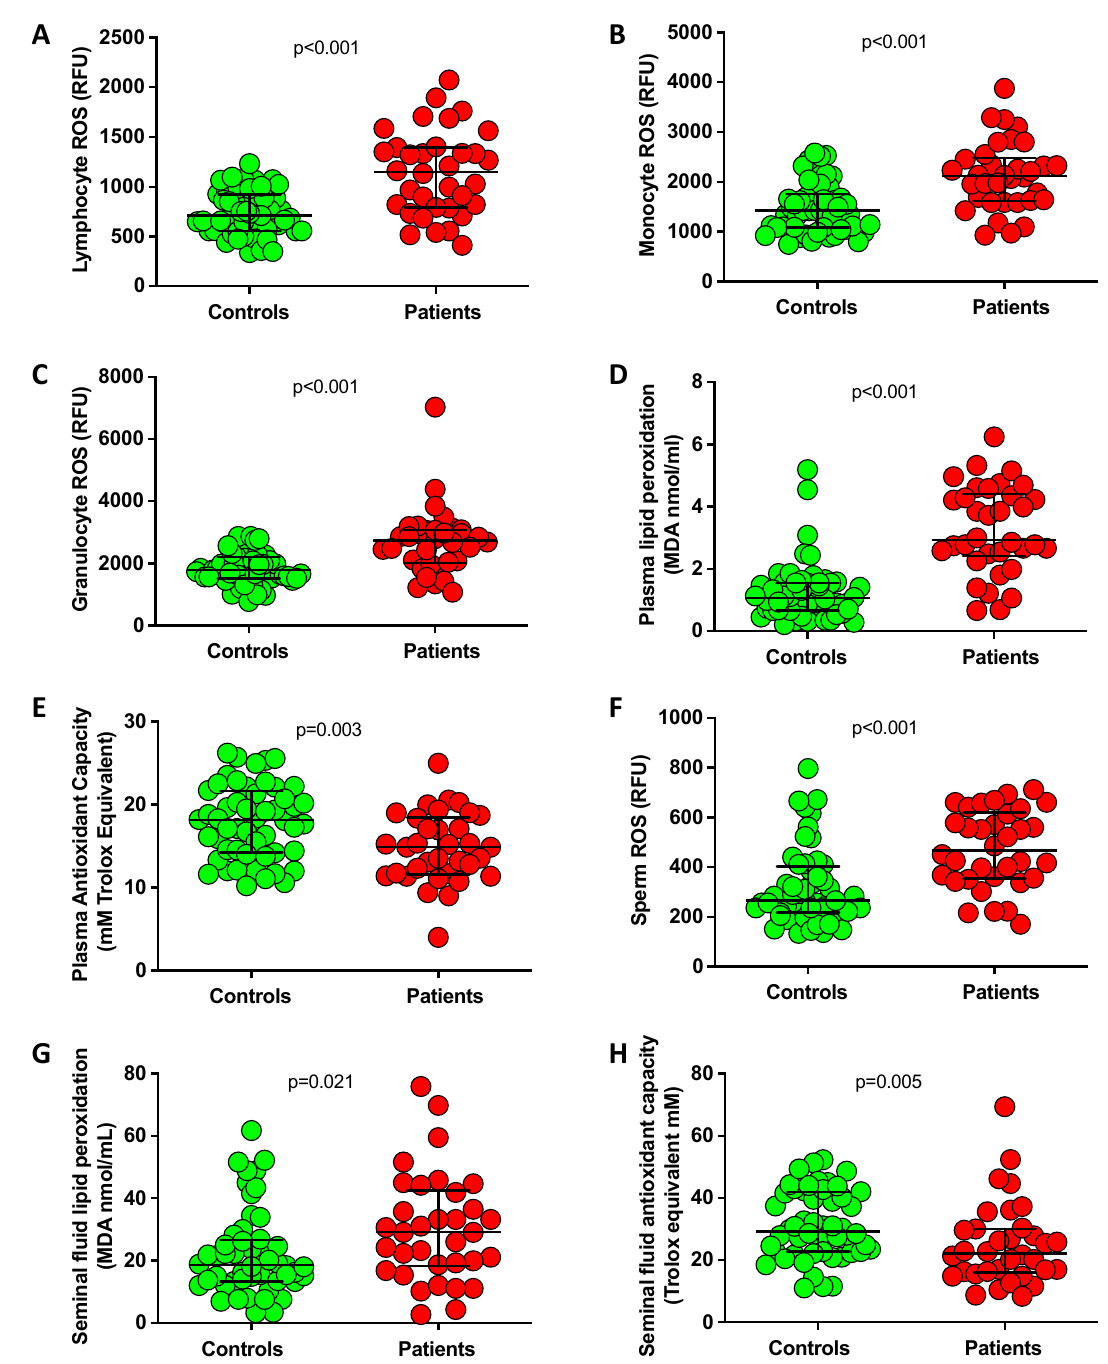
Figure 1. Median (IQR) values and patient-level measures of lymphocyte ( A ), monocyte ( B ) and granulocyte ( C ) ROS production, plasma lipid peroxidation ( D ), plasma total antioxidant capacity ( E ), sperm ROS production ( F ), seminal fluid lipid peroxidation ( G ) and seminal fluid TAC ( H ) in infertile patients ( n = 34) and controls ( n = 52). p -values are from Mann–Whitney test for unpaired data.